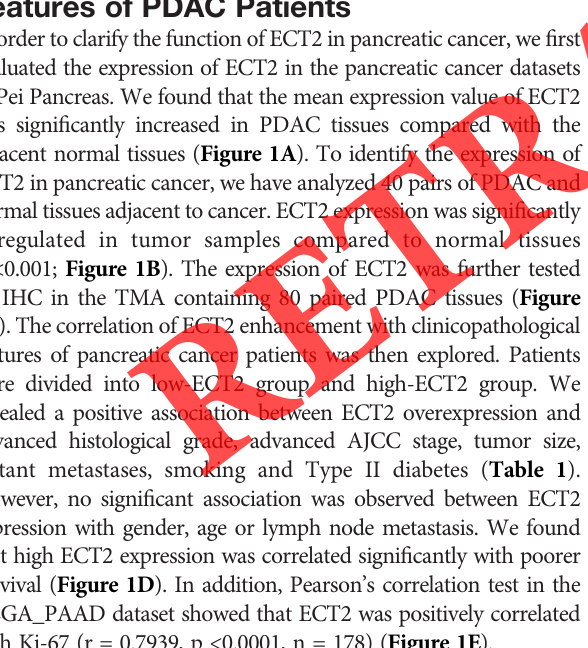
TABLE 1 | Association between epithelial cell transforming 2 (ECT2) expression and the clinicpathological features of PDCA.